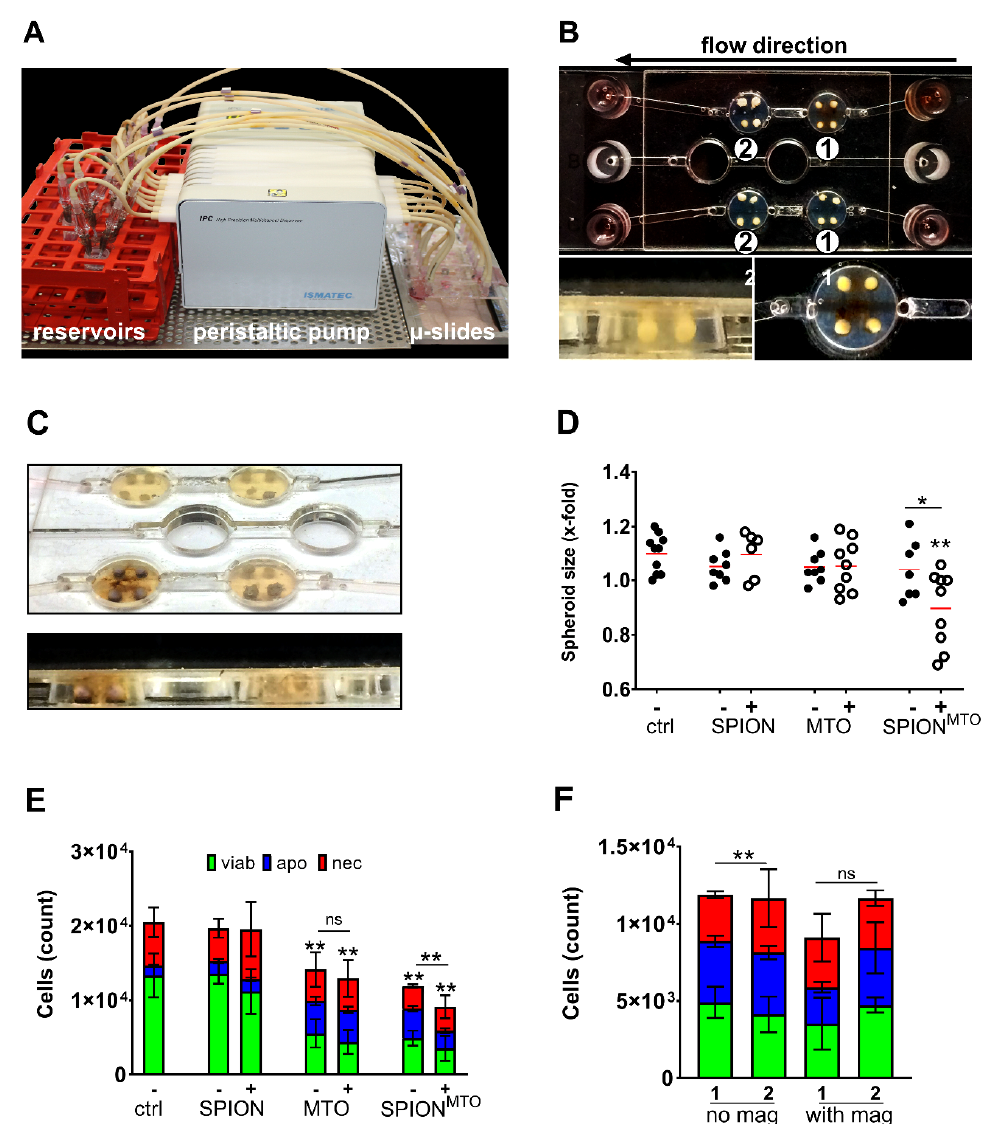
Figure 5. Magnetic accumulation of SPION MTO in spheroids under dynamic flow conditions. ( A ) Experimental setup. A peristaltic pump transported 3 mL of medium through the Ibidi µ -slides at a constant flow rate of 0.5 mL / min. ( B ) HT-29 spheroids were added in holes pierced into the agarose coating of the flow slides. Magnets were positioned under the first wells of a row in the slides. ( C ) SPION deposits were visible around spheroids after magnetic accumulation. No change in color was observed in wells treated without magnet. ( D ) Sizes of the spheroids on day 4 after treatment with SPION, MTO or SPION MTO +/ − magnet. Mock treated cells served as controls. Sizes were normalized to the spheroid sizes before treatment. ( E ) AnnexinA5-FITC / propidium iodide (Ax / PI) staining of monocell suspensions prepared from spheroids on day 4 after treatment. ( F ) Comparison of cell counts (Ax/PI staining) between first and second well in serial flow. Two separated circulation systems (no magnet/with magnet) consisted of two wells in serial flow (1/2), each containing 4 spheroids exposed to SPION MTO . In the circulation system including a magnetic field, the magnet was positioned under only the first well (“1” in group “with magnet”). Well 2 was without magnet. Experiment was performed in two independent experiments each with four spheroids per condition. Shown are the mean values with standard deviations. Significances were calculated for total cell counts using Student‘s t -test (* p ≤ 0.05, ** p ≤ 0.01, control versus treated samples or with versus without